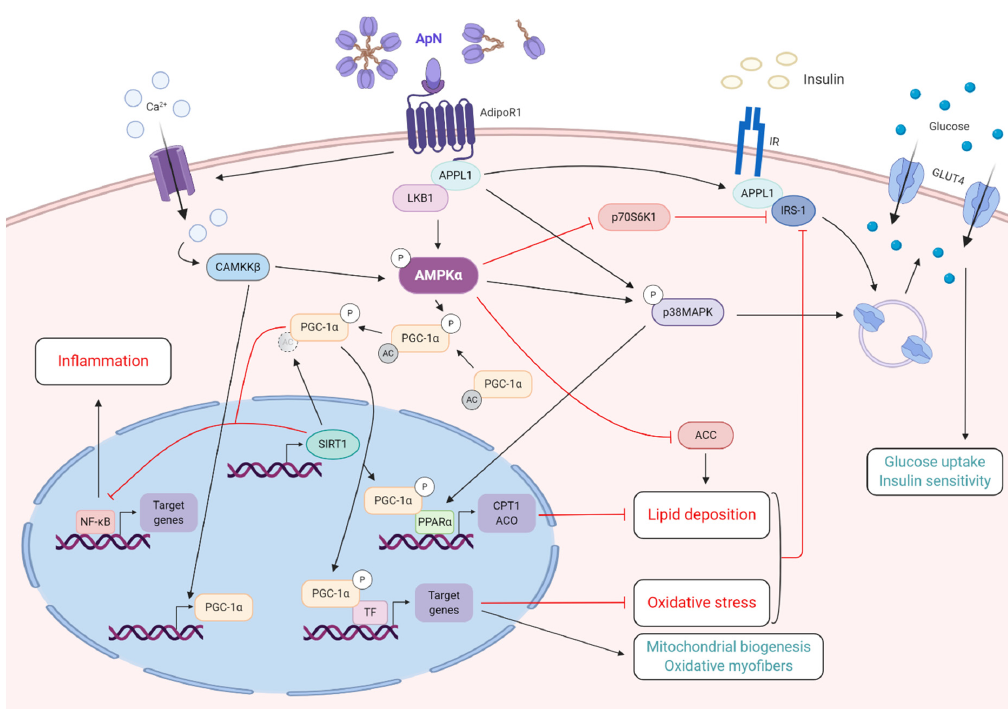
Figure 2. Adiponectin properties on healthy skeletal muscle. This figure summarizes the main metabolic effects of ApN, while specifically highlighting a central crosstalk between ApN ‐ AdipoR1 ‐ AMPK and insulin pathways. Briefly, binding of ApN to AdipoR1 will recruit LKB1 and increase calcium influx, both required to fully activate AMPK ‐ SIRT1 ‐ PGC ‐ 1 α axis. Then, AMPK signaling will repress the activity of NF ‐κ B and decrease muscle inflammation. It will also increase, via PGC ‐ 1 α , mitochondrial biogenesis and function and favors an oxidative myofiber phenotype, while markedly decreasing oxidative stress. In addition, this pathway will limit and reduce lipid deposition via direct action, through inhibition of ACC, or indirect one, through activation of PPAR α and its target genes ( CPT1 and ACO ). Eventually, decrease in muscle oxidative stress and lipid content, as well as inhibition of p70S6K1, will significantly reduce insulin resistance. Finally, ApN could also boost insulin sensitivity and glucose uptake by promoting IRS1 binding to insulin receptor and by activating p38MAPK, respectively. Pointed head black arrows indicate activation or induction, while blunt head red arrows indicate inhibition. Dashed and blurred circle represents removal of the indicated residue. Boxes with processes in green represent net beneficial effects of ApN, while boxes with processes in red represent metabolic dysfunctions counteracted by ApN. ApN, adiponectin. TF, transcription factors. Created with BioRender.com.